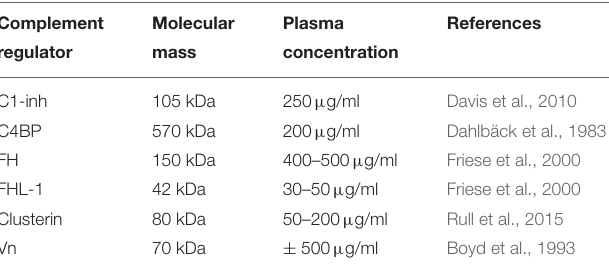
TABLE 1 | Overview of molecular mass and plasma concentrations of soluble complement regulatory